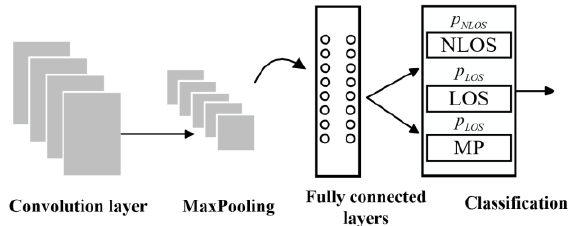
Figure 2. CNN structure for NLOS, LOS and MP